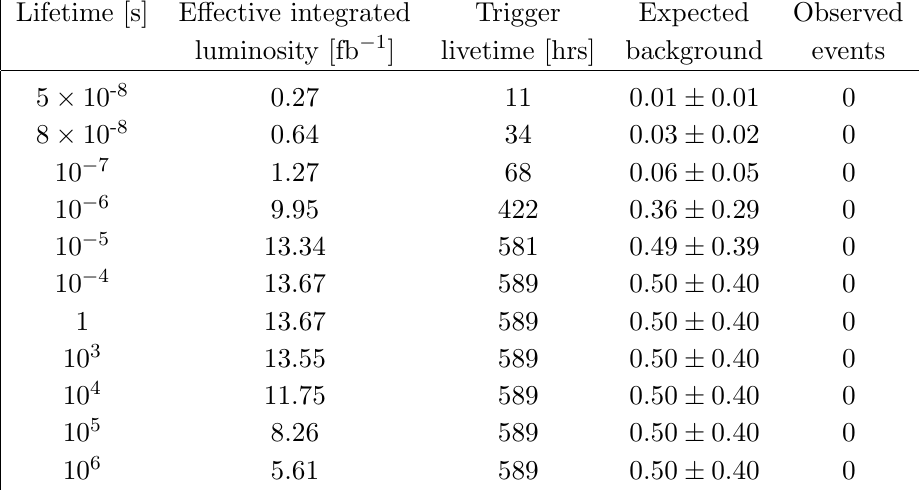
Table 8 . Counting experiment results for di(cid:11)erent lifetimes in the muon search with 2016 data.